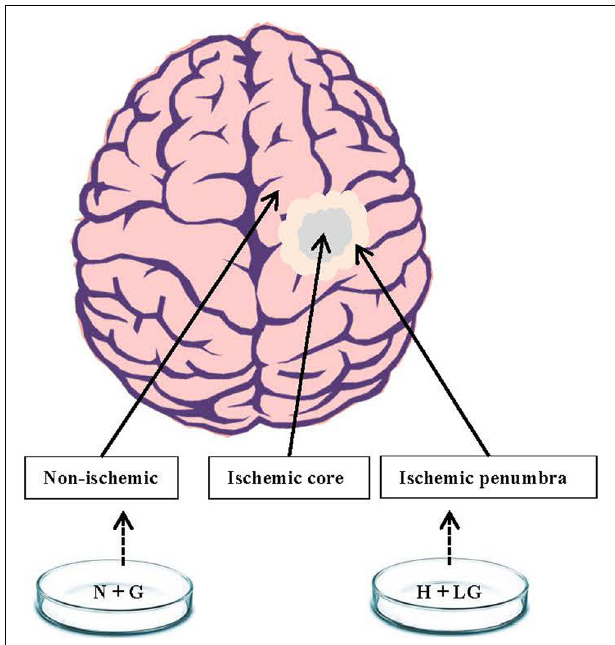
FIGURE 1 | A schematic diagram showing ischemic penumbra and non-ischemic regions of the brain. We postulated that HT22 cells under hypoxia with low glucose (H+LG) for 17.5 h treatment could mimic the cells in the ischemic penumbra region while cells under normoxia with 22 mM glucose (N+G) treatment would be similar to non-ischemic